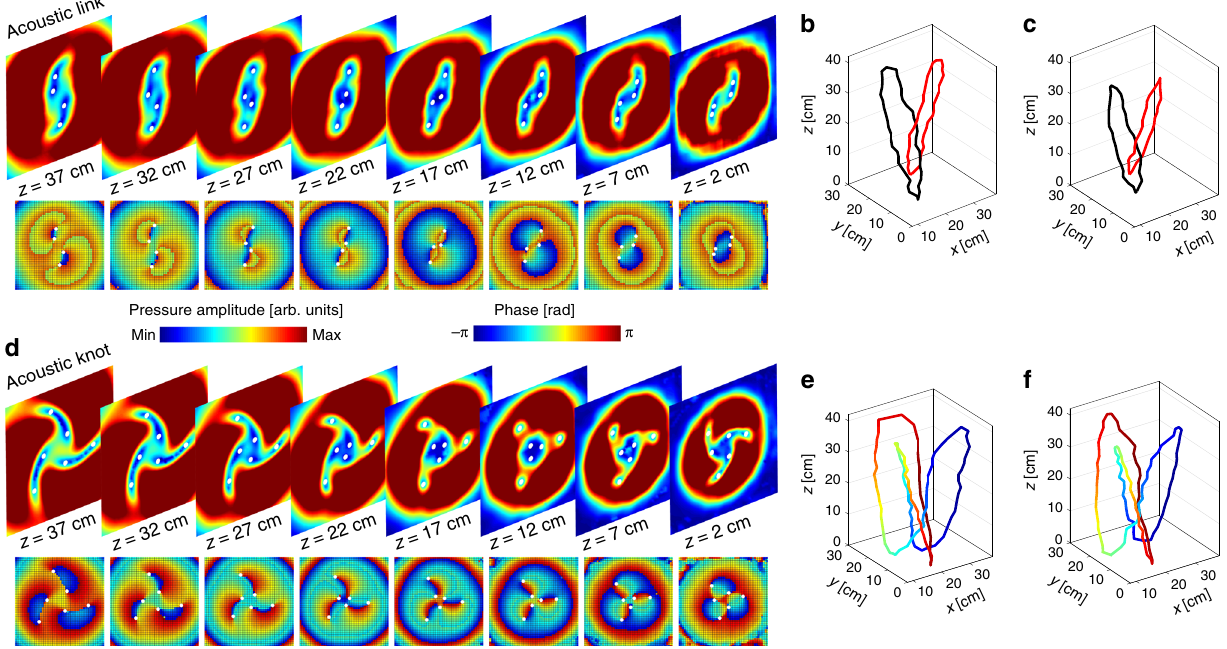
Fig. 3 The measured acoustic fi elds with Hopf link and trefoil knot vortex lines. The left charts show the amplitude and phase distributions at different z - plane for a Hopf link and d trefoil knot. The white dots possessing the singular phase represent the vortices. The right charts plot the experimental Hopf link ( b ) and trefoil knot ( e ) as well as simulation ones ( c , f ), where the color marked on the vortex lines is used to distinguish the knotted structure with overlapped